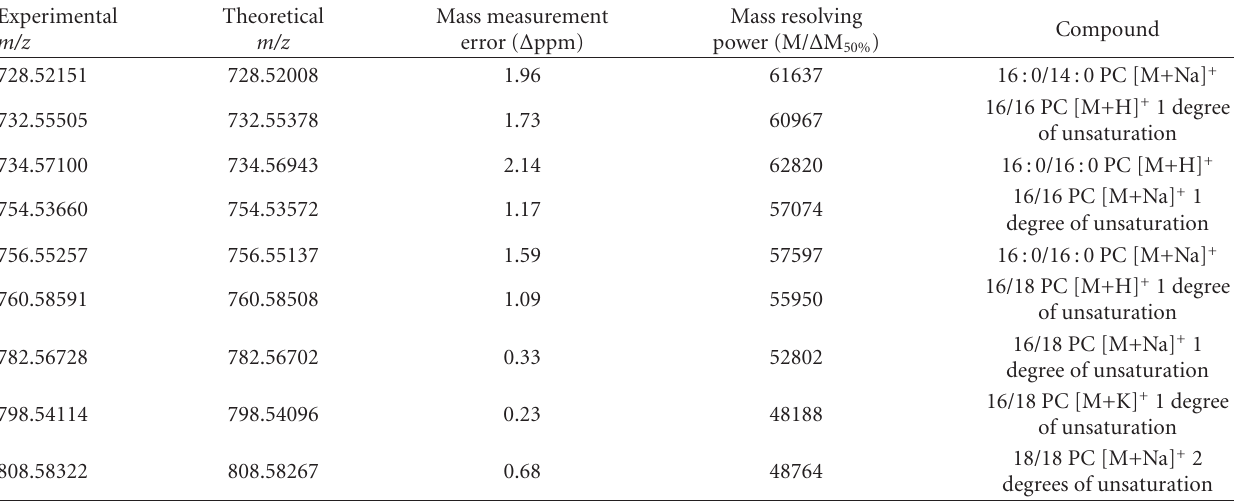
Table 3: CLSE compounds identified using paper spray mass spectrometry. The phospholipids detected are denoted using the lipid numbers nomenclature to indicate degrees of unsaturation, and PC refers to phosphatidylcholine. The CLSE mass spectrum was obtained with excitation and detection frequency range of 1.5 MHz.